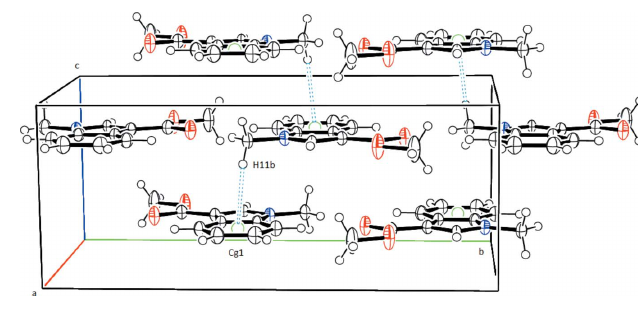
Figure 2 A view of the C—H (cid:2)(cid:2)(cid:2) O hydrogen bonds (dashed lines) present in the crystal structure of the title